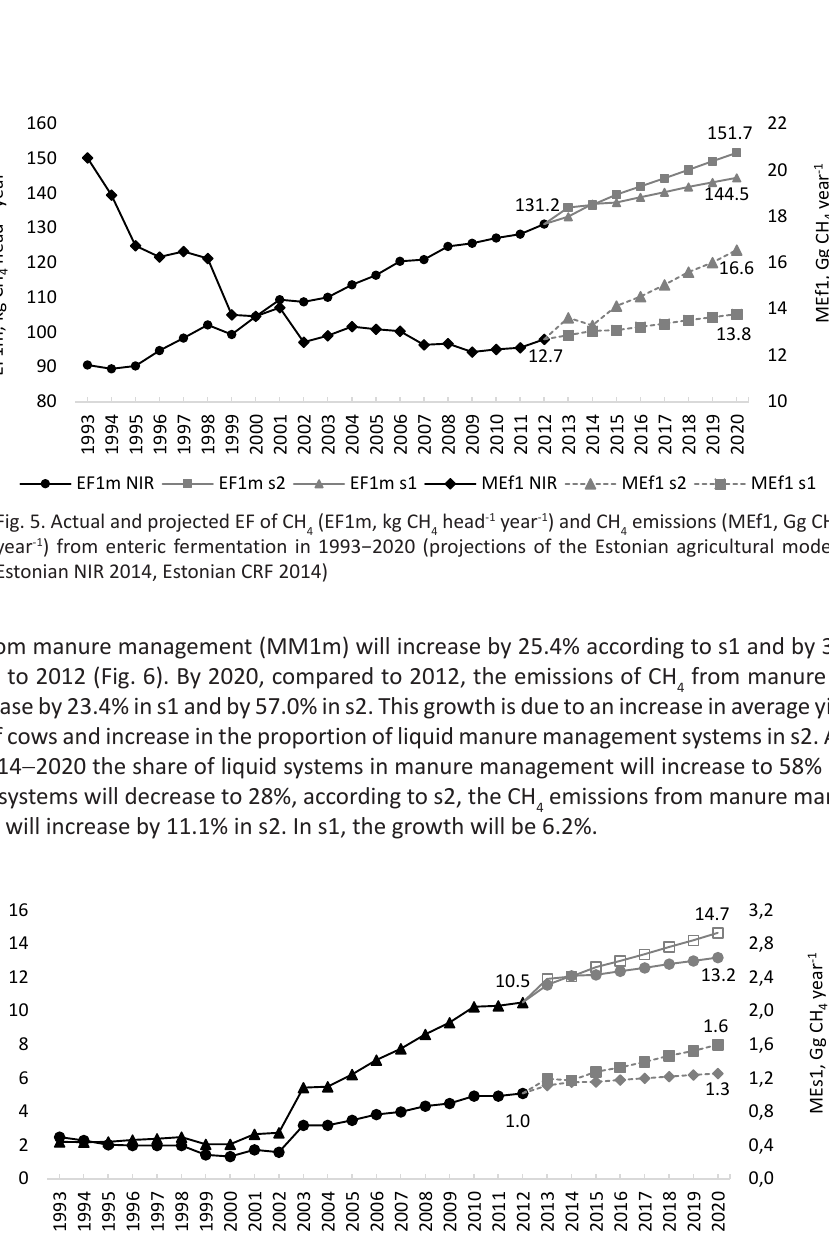
(MM1m, kg CH head -1 year -1 ) and CH emissions (MEs1, Gg CH 4 4 4